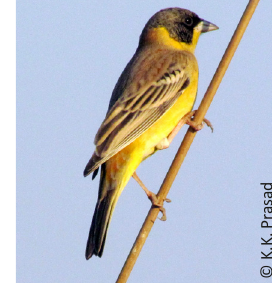
Image 69. Black-headed Bunting Emberiza melanocephala